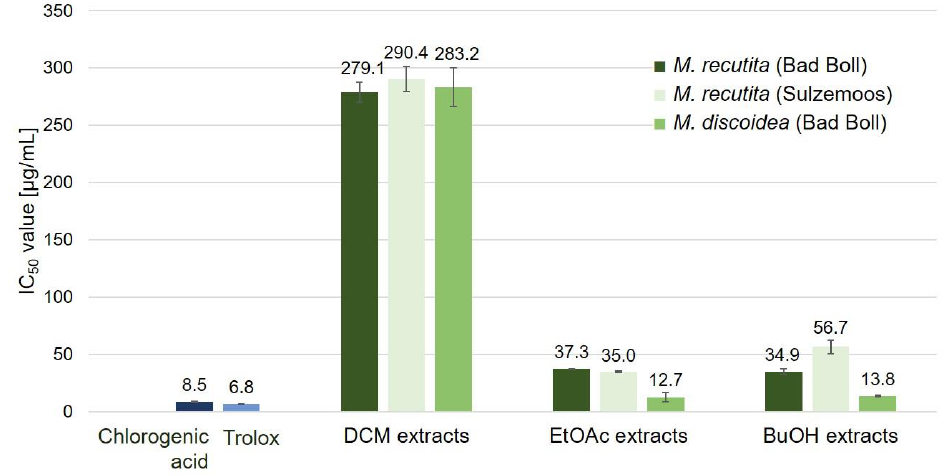
Figure 7. IC 50 values of different chamomile root extracts, trolox and chlorogenic acid determined applying the DPPH radical scavenging assay ( n = 3).